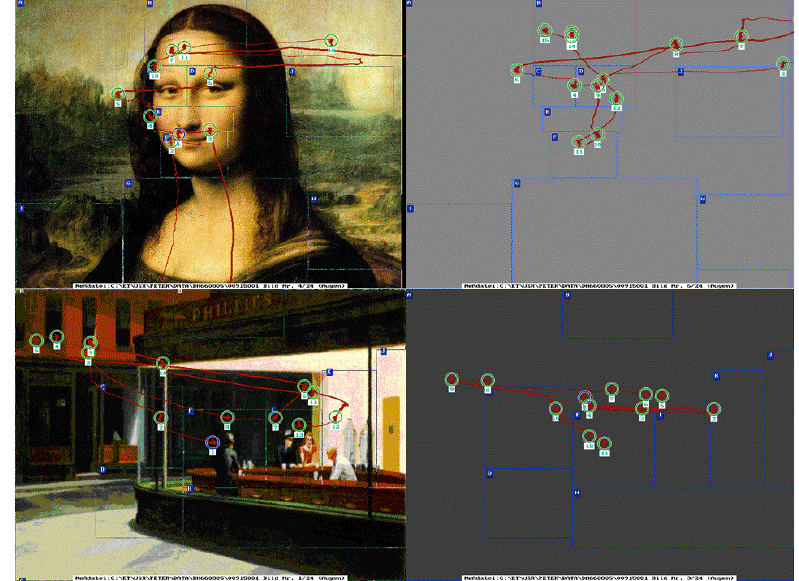
Figure 2. Demonstration of eye movement scanpaths of picture viewing (left) and subsequent visual imagery of two famous art works: the Mona Lisa by Leonardo da Vinci, and Edward Hopper´s Nighthawks 1942, Oil on canvas, 30 x 60, in The Art Institute of Chicago. Visual stimuli in this study ranged from realistic to abstract art pictures.